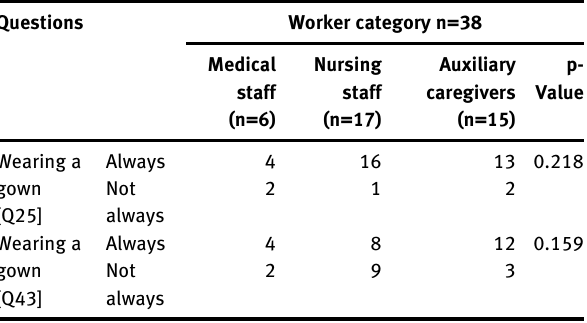
Table  B: Practice questions by worker categories.